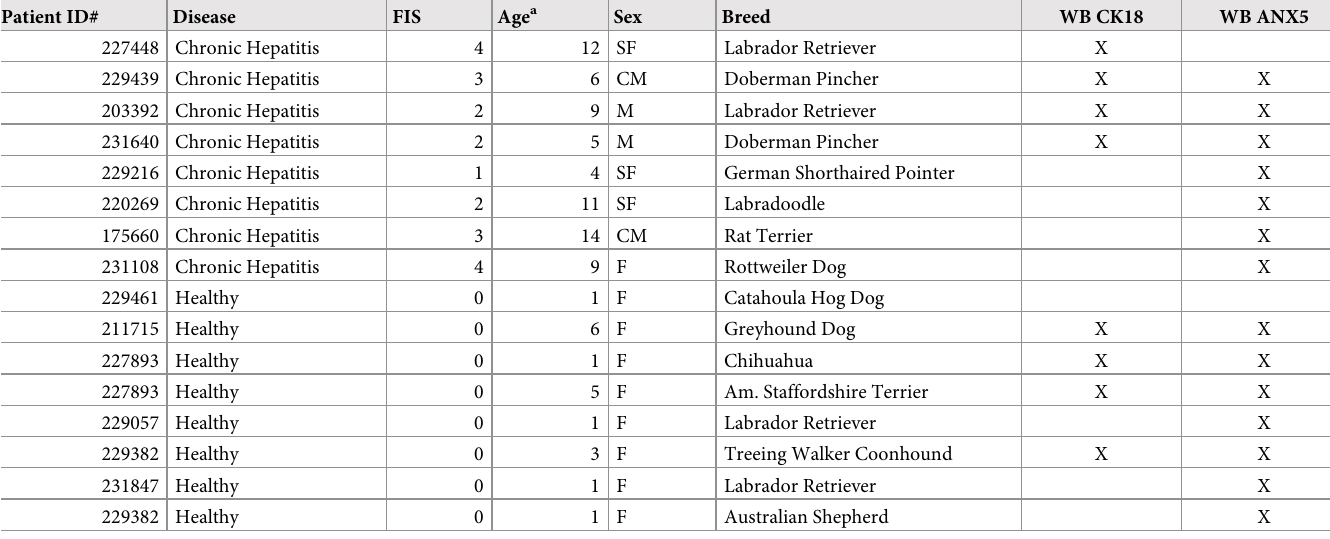
Table 3. Patient allocation for Western blot analysis.